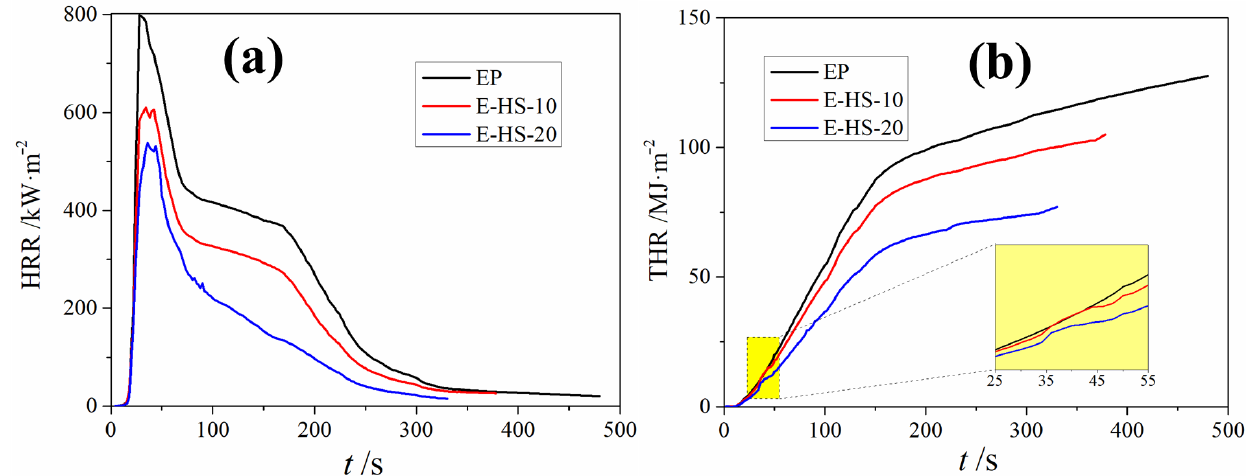
Figure 4. HRR curves ( a ) and THR curves ( b ) for samples under an external heat flux of 50 kW/m 2 .